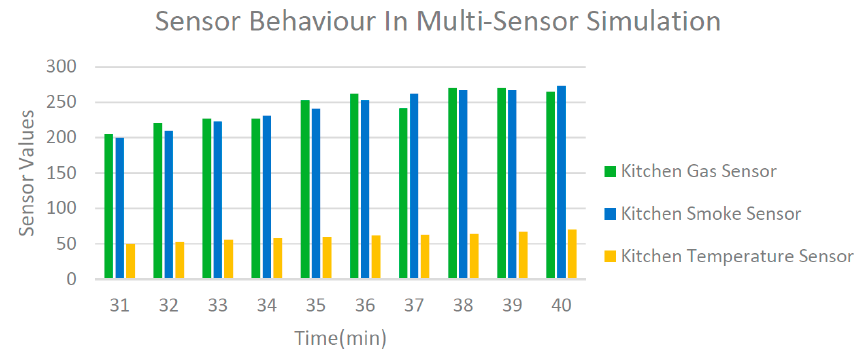
Figure 11. Sensor behavior in the multi-sensor simulation. Table 3. Table of the results from our five experiments.